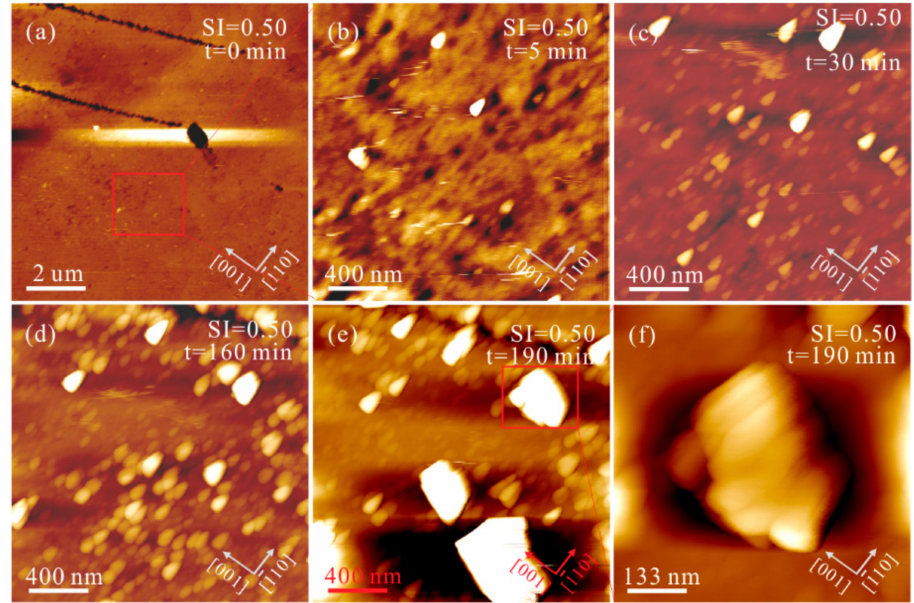
Figure 3. AFM height images of the aragonite (110) growth surface in solutions (Mg 2 + / Ca 2 + = 0, SI calcite = 0.50) under flowing conditions at pH = 8.0 ± 0.1 for ( a ) 0, ( b ) 5, ( c ) 30, ( d ) 160 and ( e ) 190 min, and ( f ) denotes the same zone marked with red box in ( e ). The region marked with the red box in ( a ) represents the same zones in ( b – e ).